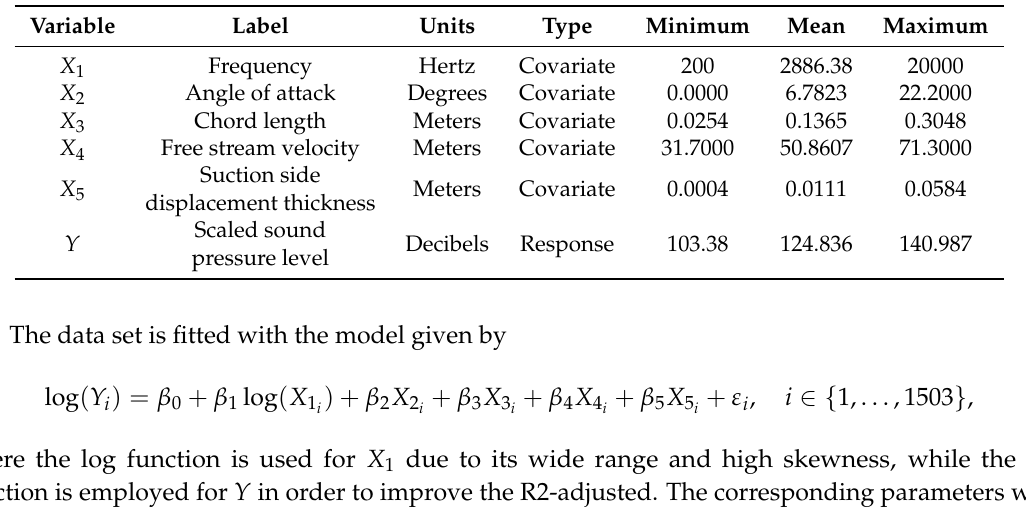
Table 6. Description of the variables in the airfoil self-noise data